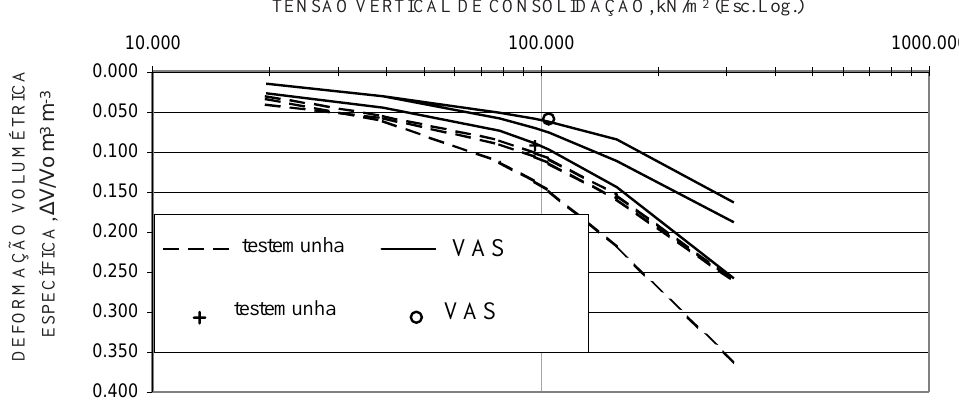
Figura 9. Curvas de adensamento e valores médios de pressão de pré-adensamento (+ o) em amostras extraídas com o VAS e com as testemunhas retiradas pelo método do bloco